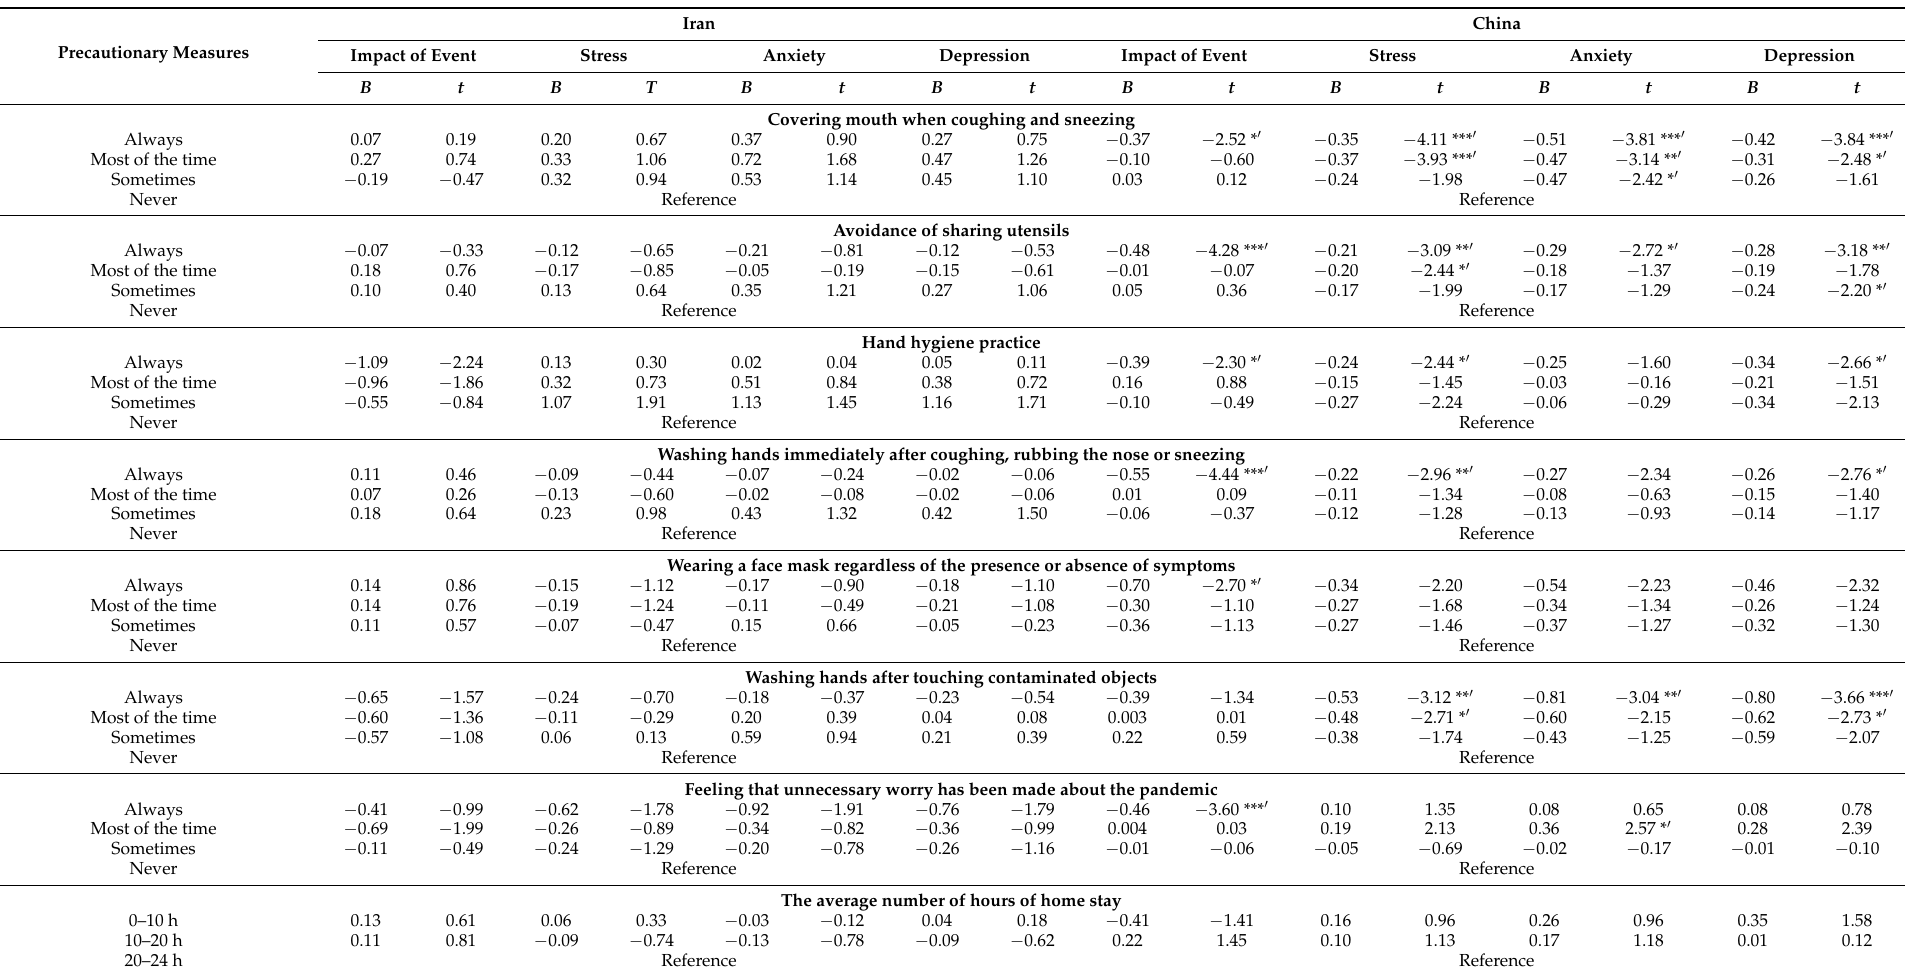
Table 4. The linear regression analysis between precautionary measures related to COVID-19 and mental health parameters in Iranian and Chinese participants ( n = 1411). Iran Precautionary Measures